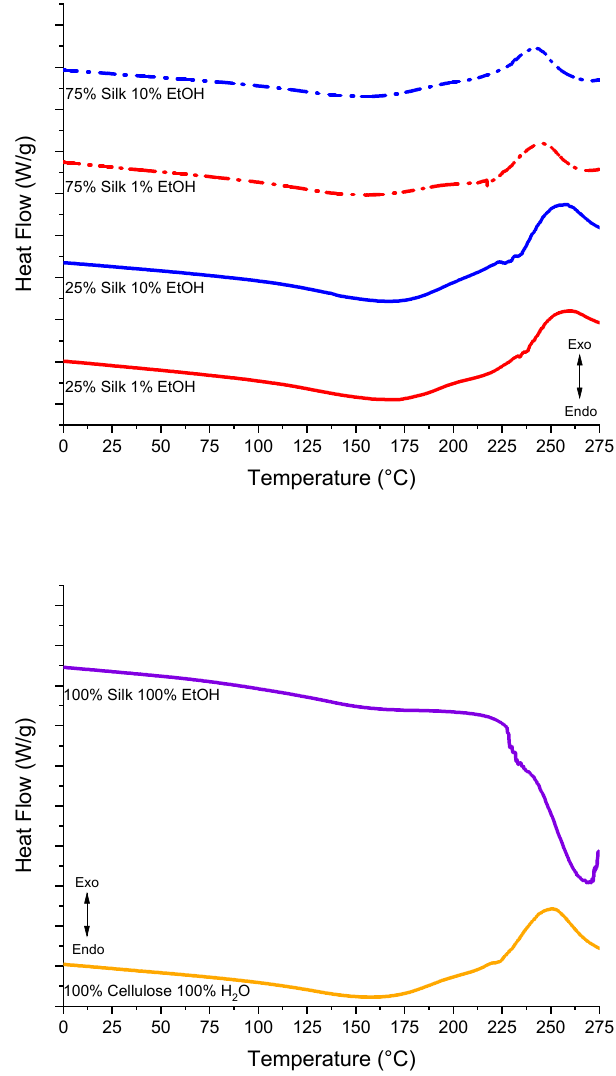
Figure 5. Differential scanning calorimetry (DSC) heat flow scans of the varied composition silk/cellulose biocomposite films and 100% regenerated samples used to determine the glass transition temperatures. Table 3. Glass transition temperatures of varied composition films and 100% regenerated samples, determined by DSC in degrees Celsius and Kelvin.